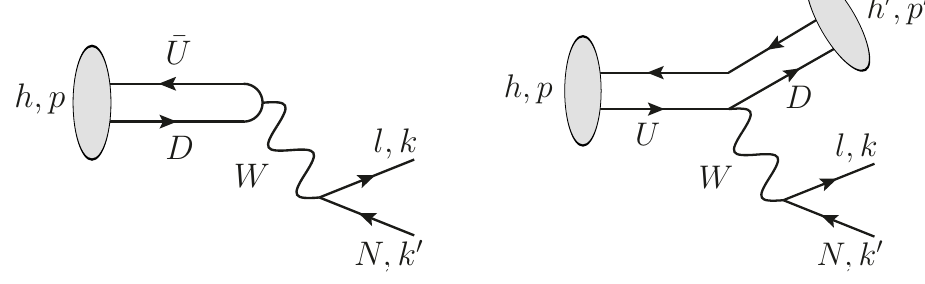
Figure 2 . Left: the diagram of leptonic decay of the meson h with 4-momentum p . Right: the diagram of semileptonic decay of the meson h with 4-momentum p into meson h 0 with 4-momentum p 0 . In both diagrams the transferred to the lepton pair 4-momentum is q = k + k 0 . The only possible production channel from the (cid:25) + is the two body decay (cid:25) + with ‘ = e; (cid:22) . The production from K + is possible through the two-body decay of the same type. There are also 3-body decays K + The resulting branching ratios for corresponding mesons are shown in (cid:12)gure 3. For small HNL masses the largest branching ratio is that of K 0 suppression in the two-body decays and small K 0